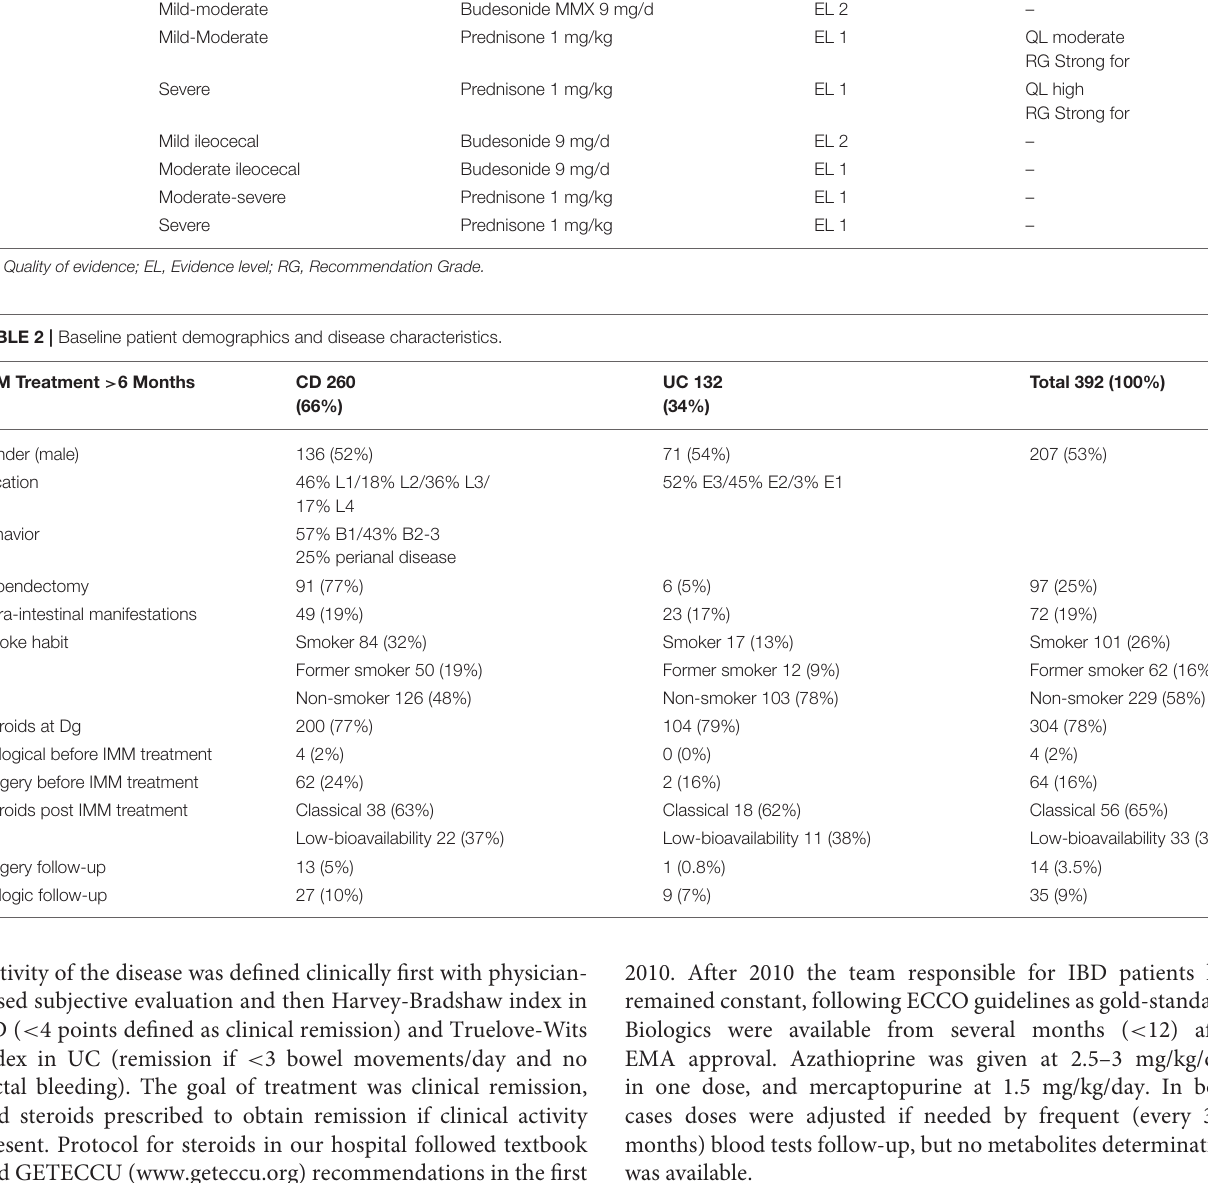
TABLE 1 | Level of evidence and indications for use of corticosteroids in patients with IBD.